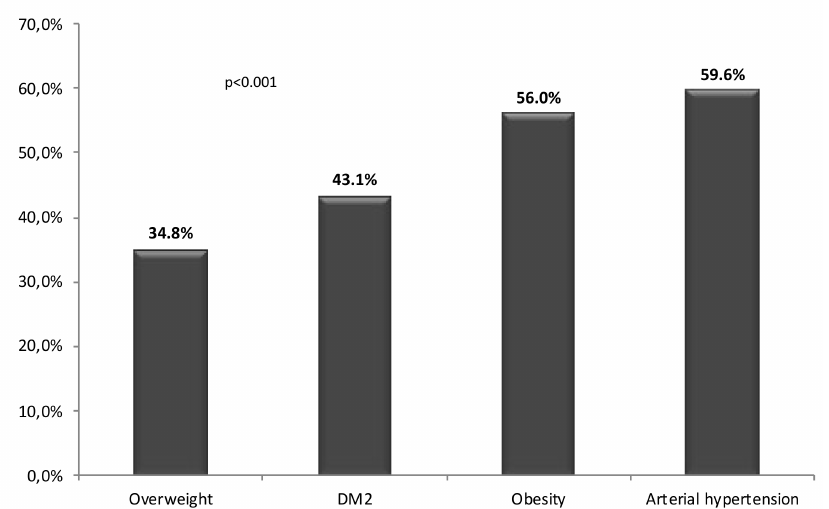
Figure 6. Prevalence of comorbidities in the population a ff ected by early kidney disease.